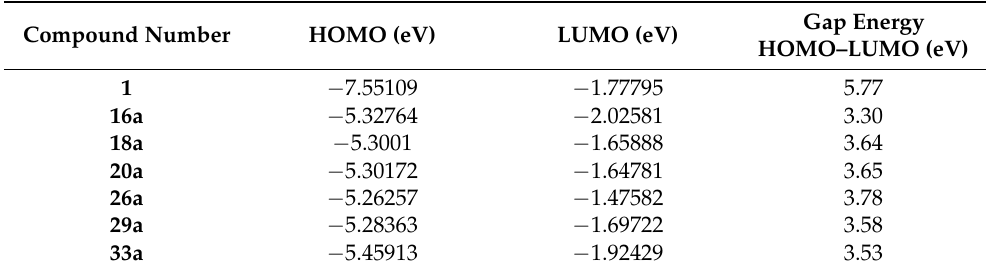
Table 4. HOMO energy, LUMO energy and LUMO–HOMO energy gap of compounds calculated using the DFT (B3LYP)/6–31 + G(d) method.